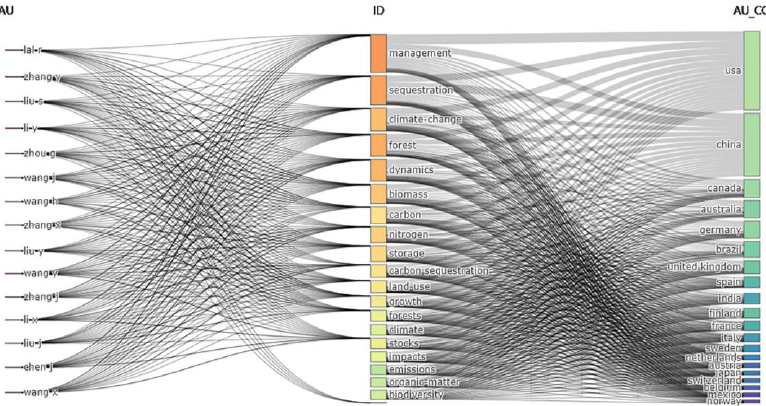
Figure 10. Relationship between authors ( left ), keywords plus ( middle ), and countries ( right ).